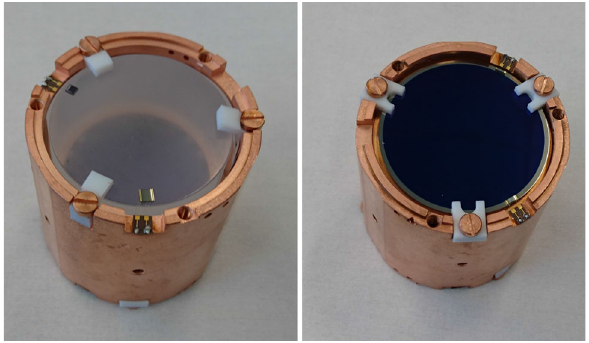
Fig. 4 An assembled CUPID-Mo module. On the left: view from the top, the semi-transparent crystal surface where the NTD and heater are located. On the right: view from the bottom, germanium LD with SiO coating (dark blue internal circle); the 2 mm on the edge of the wafer (17% of the area) are uncoated